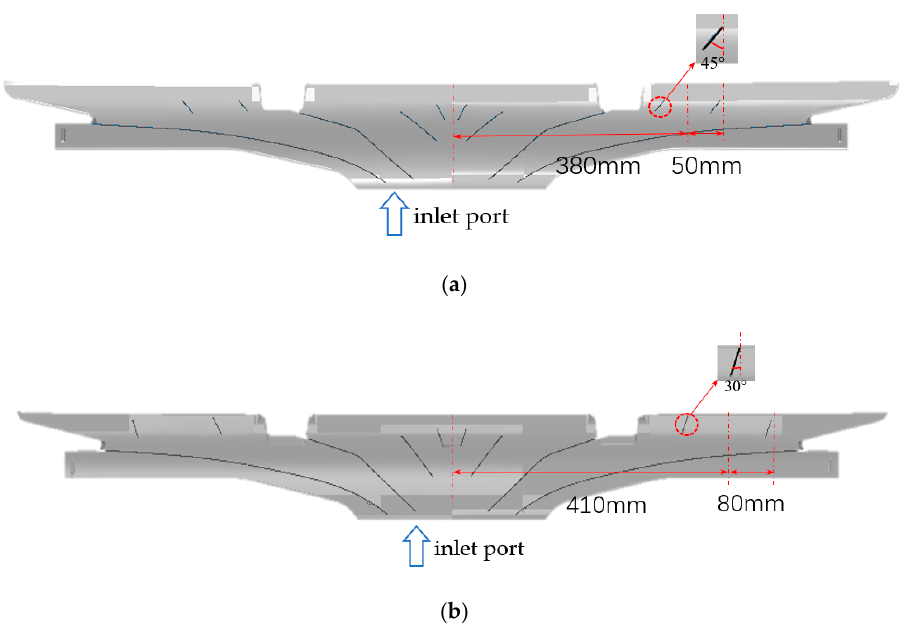
Figure 10. Defrosting duct. ( a ) Original defrosting duct; ( b ) optimized defrosting duct.